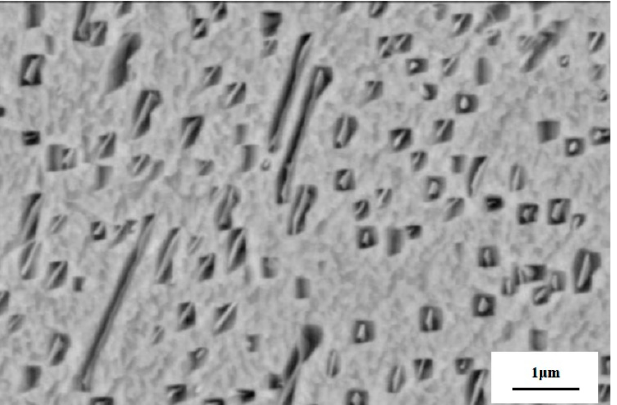
Figure 13. SEM images of the precipitated strengthening phase from γ grains in the aged Cu–Ni–Sn alloy [51]